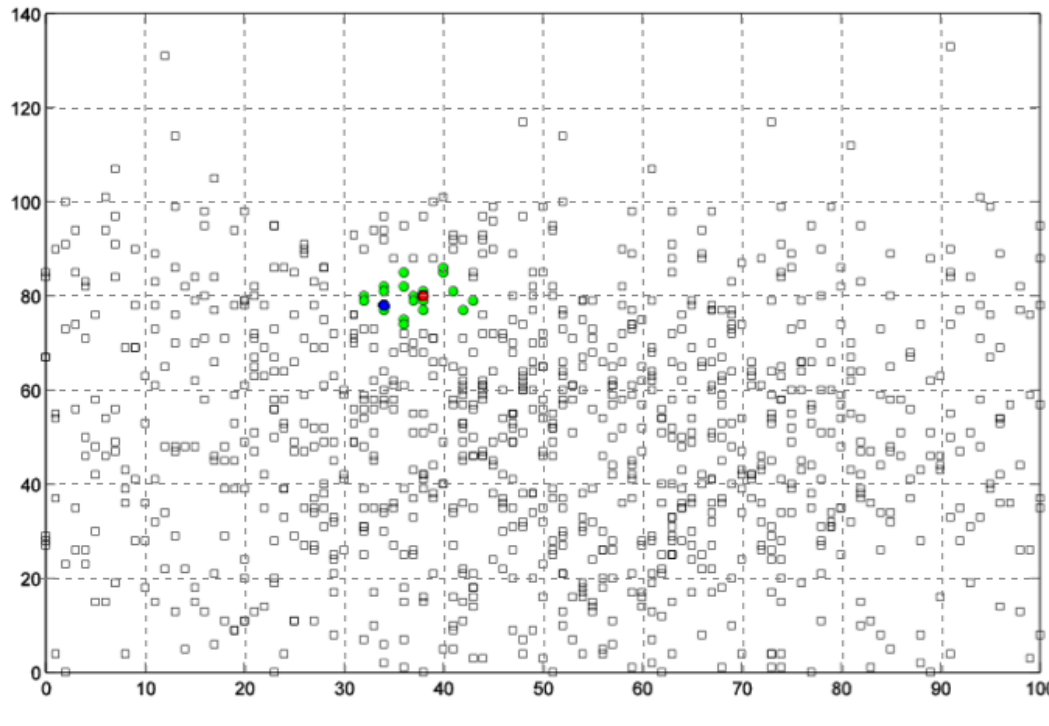
Figure 5. A demo of